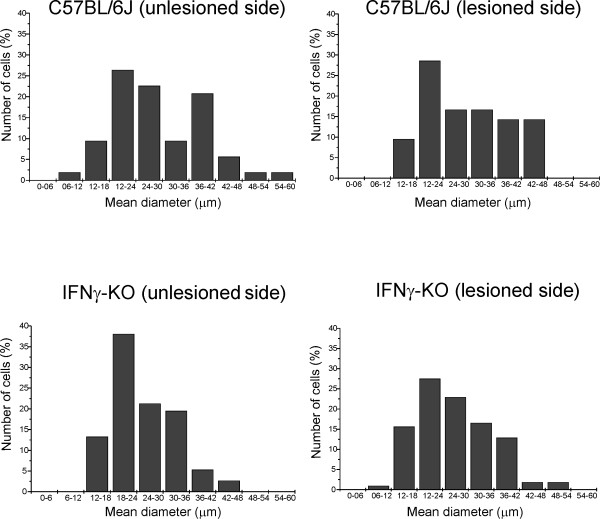
Motoneuron somata mean diameter (μm), one week after the unilateral transection of the sciatic nerve in C57BL/6J and IFNγ-KO mice. (A) Bimodal distribution in the C57BL/6J on the unlesioned side, with a clear through at 30-36 μm. (B) Lesioned side with non-bimodal size distribution. (C) Size distribution in the IFNγ-KO on the unlesioned side, the cell diameter is especially concentrated at 18-24 μm. (D) Lesioned side of the IFNγ-KO mice also showed a non-bimodal size distribution.